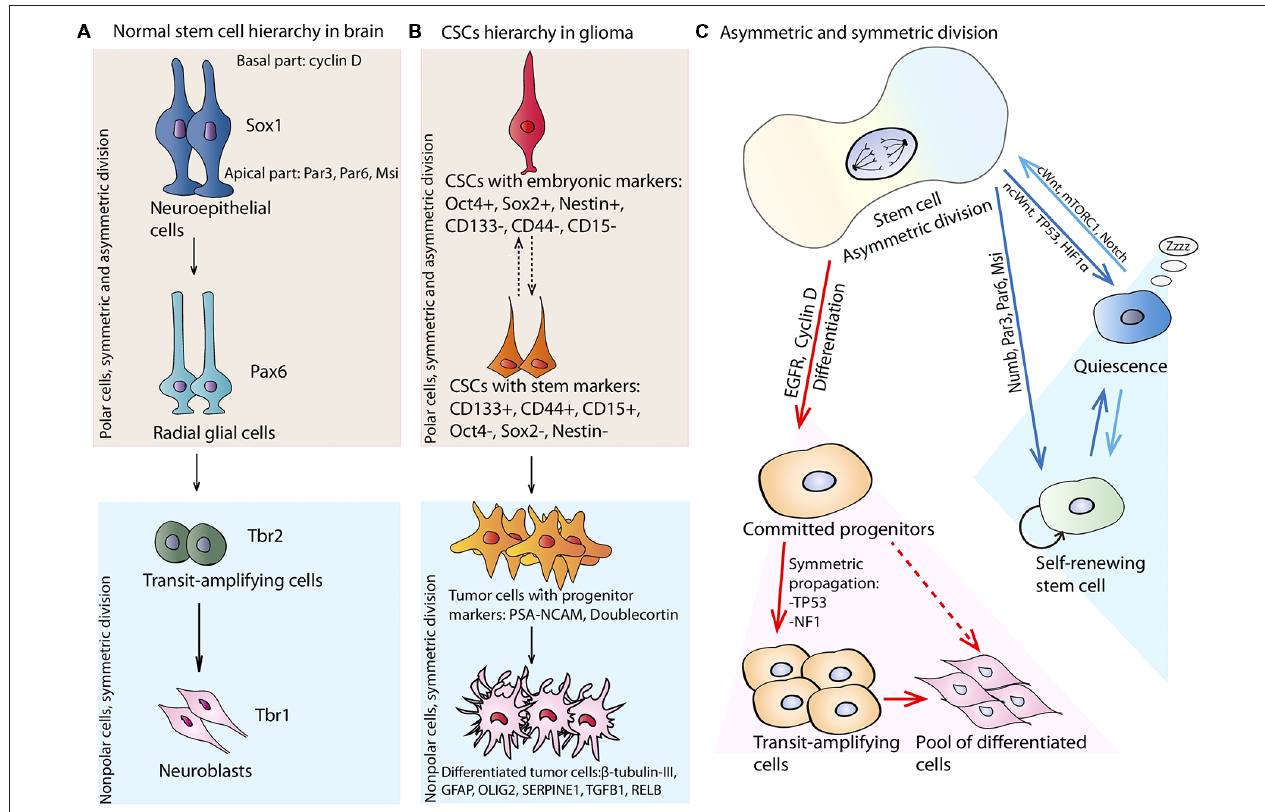
FIGURE 2 | Stem cell hierarchy and division. (A) Normal neural stem cells (NSCs) hierarchy: neuroepithelial cells expressing signature transcription factor—Sox1, are polar cells capable of asymmetric division. Apical parts of the cells are enriched with Par3, Par6 and musashi-1 (Msi); basal parts collect cyclin D. Neuroepithelial cell through division can generate more differentiated cells—radial glial cells expressing paired type homeobox 6 (Pax6), which are also polar and can divide asymmetrically. They can produce more differentiated cells—transit-amplifying cells, expressing Trb2 and capable of fast expansion. They can divide only symmetrically and committed to differentiation in neuroblasts. Neuroblasts are symmetrically dividing nonpolar cells expressing Trb1. (B) CSCs hierarchy in glioma. Initiating glioma CSCs expressing embryonic transcription factors—Oct4, Sox2 and Nestin. These cells are probably capable of asymmetric division with generation of more differentiated cells expressing stem cell markers—CD133, CD44 and CD15. Separation of glioma CSCs on less differentiated and more differentiated is not strict as the phenotype of these cells highly depends on the phenotype of the cell of origin. CSCs can generate more differentiated cells with progenitor markers: PSA-NCAM and Doublecortin which amplify the general tumor cell pool and can become more differentiated with generation of cells expressing β -tubulin-III, glial fibrillary acidic protein (GFAP), OLIG2, SERPINE1, TGFB1, RELB. (C) Stem cell symmetric and asymmetric division. NSC can divide asymmetrically by generating two daughter cells with different fate: one cell inherits EGFR and Cyclin D that poise the cell to rapid symmetric cycling, and the other gets Numb, Par6, Par3 and Msi preventing differentiation programs. If during symmetric or asymmetric division NSC experiences the influence of ncWnt, TP53, or hypoxia-inducible factor 1 alpha (HIF1 α ) pathways it can enter the quiescent state. If quiescent NSC receives signals from cWnt, mTORC1, or Notch pathways it can enter cell cycle and divide symmetrically or